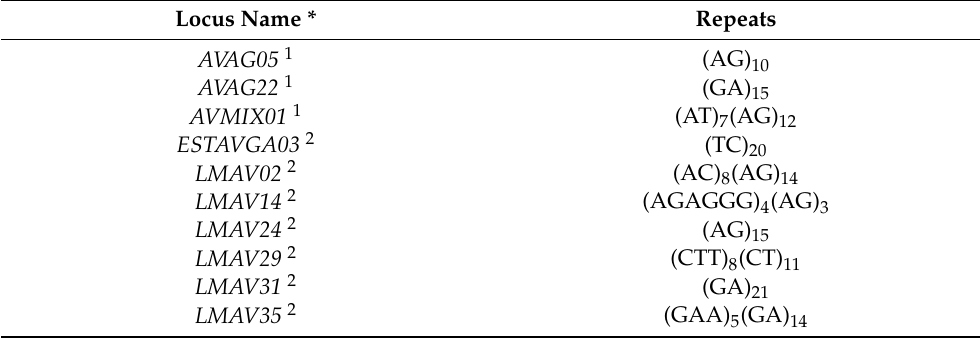
Figure 2. Measuring some morphological traits and collecting leaf samples. Table 2. The repeat motif of the simple sequence repeat (SSR) loci used in this